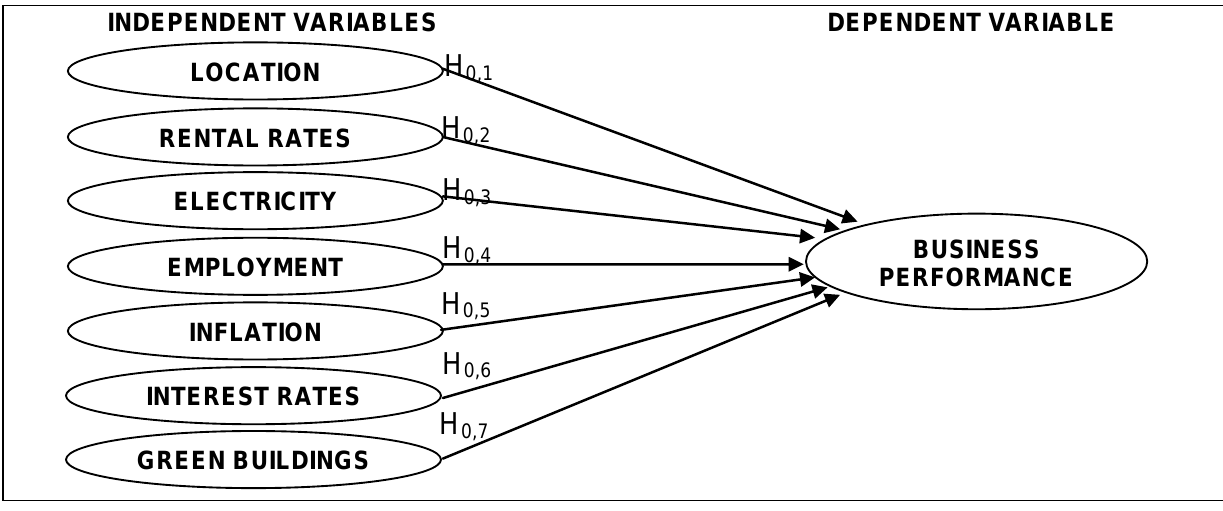
Figure 1: Seven independent variables affecting business performance INDEPENDENT